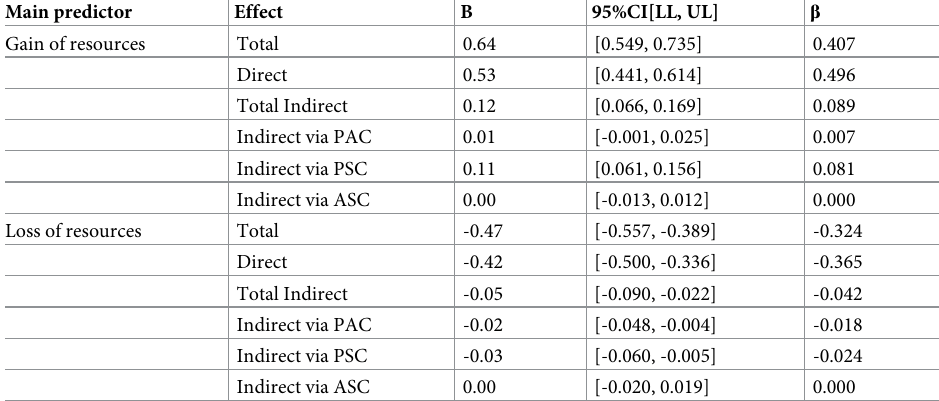
Table 2. Total, direct, and indirect effects of resources gain and loss on quality of life through coping strategies ( N = 1037). Main